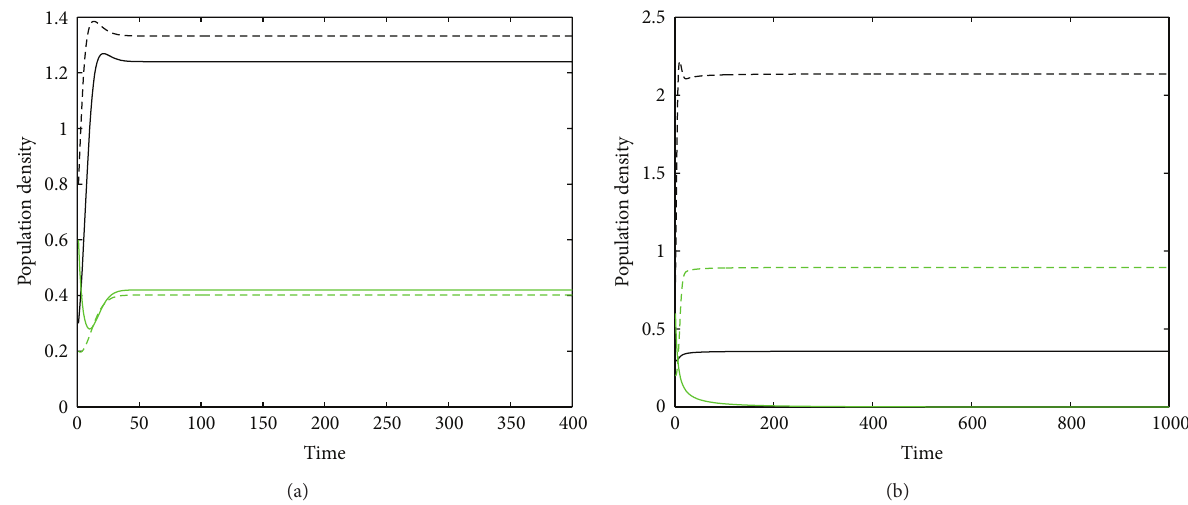
Figure 3: The dynamics of models (34) and (35). (a) is the dynamics of (34). It is observed that model (34) is permanent. (b) is the dynamics of (35). It is observed that the predator in patch 1 is driven to extinction when dispersal corridors are introduced. The black solid (dotted) line is the population variation of the prey in patch 1 (patch 2). The green solid (dotted) line is the population variation of the predator in patch 1 (patch